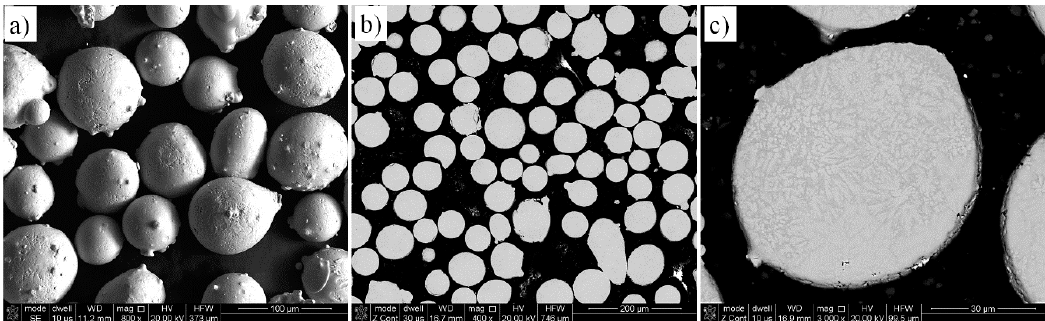
Figure 1. Initial T-800 powder: ( a ) 3D view, ( b ) metallographic cross-section, and ( c ) microstructure of the particle.